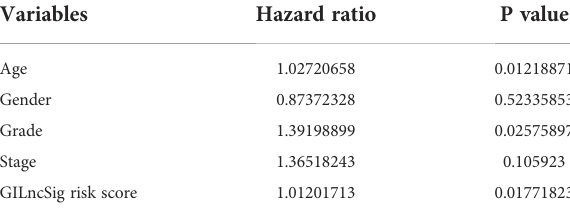
TABLE 4 Univariate Cox proportional hazard regression analysis revealed that GILncSig risk score, age and grade are signi fi cant prognostic factors.